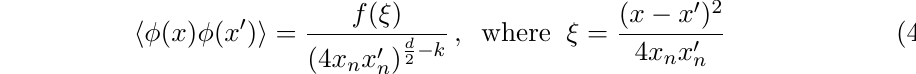
Table 4 . ∆ F ∂ | log for the boundary RG flow in the / 4